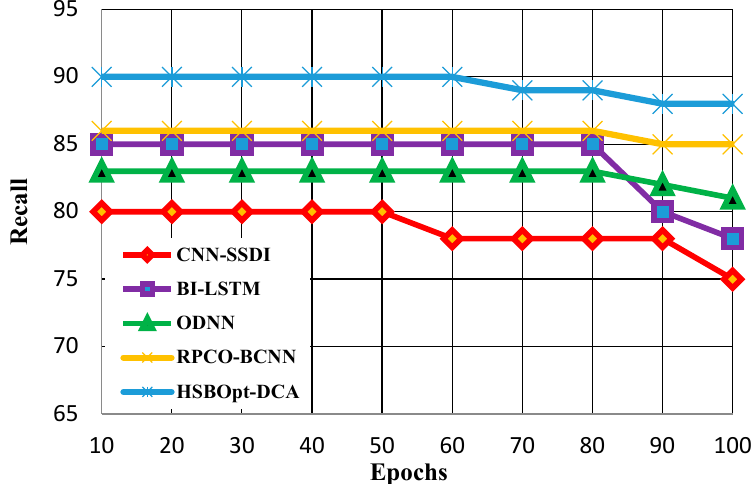
Figure 8. Recall calculation with 100 epochs.